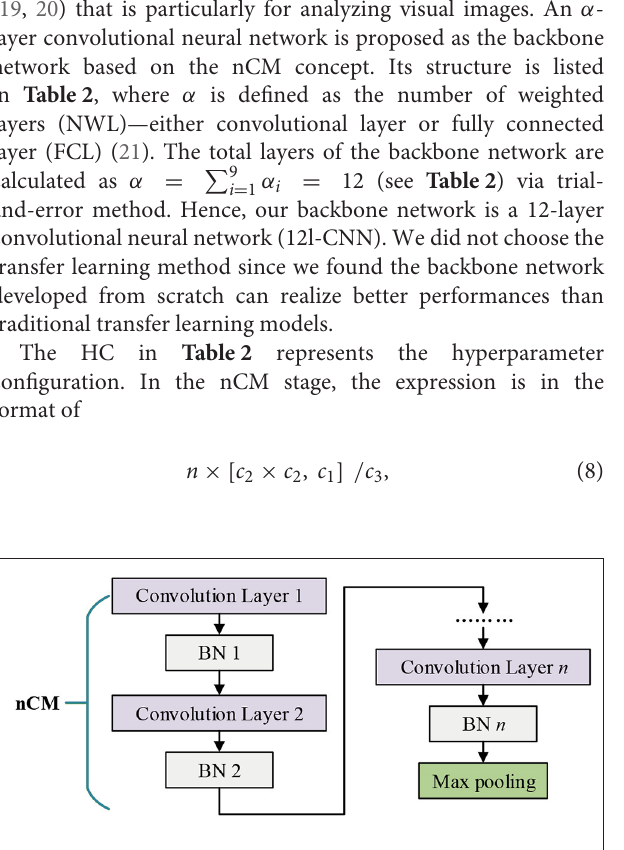
FIGURE 5 | Schematic of our n-conv module (nCM).